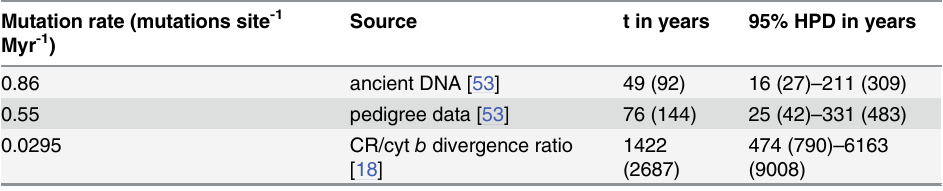
Table 3. Divergence time estimates t and 95% highest posterior densities (HPD) for Otago and Phillip Island populations based on different mutation rates. Mutation rate (mutations site